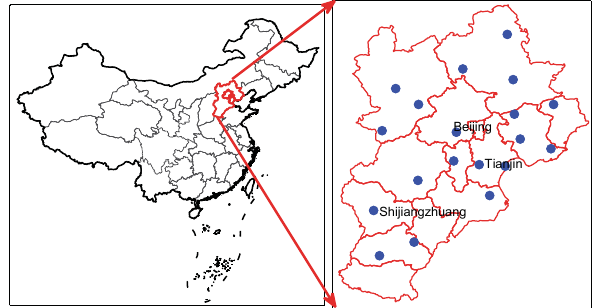
Figure 1. Research area and locations of the 19 synoptic meteoro- logical stations.